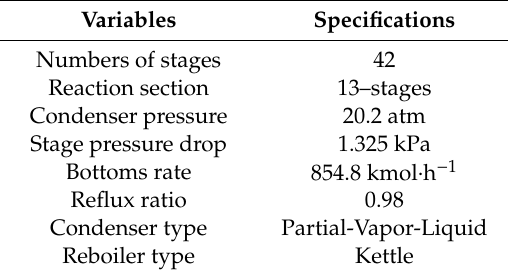
Table 5. Operational conditions for the depropanization column.